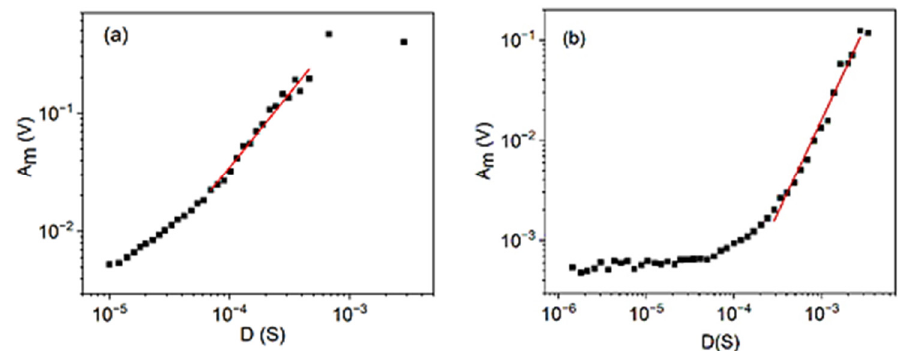
Figure 3. logA m versus logD plots for cooling in alloy A ( a ) at small, constant, external magnetic field (B = 250 mT) and for heating in alloy B ( b ) (at B = 0). The slopes (1.3 ± 0.1 and 1.9 ± 0.1, respectively), using again the same fitting windows with the same mid values of A m as in Figure 2, provide = 0.77 ∓ 0.08 and θ = 0.6 ± 0.1 for alloys A and B, respectively.